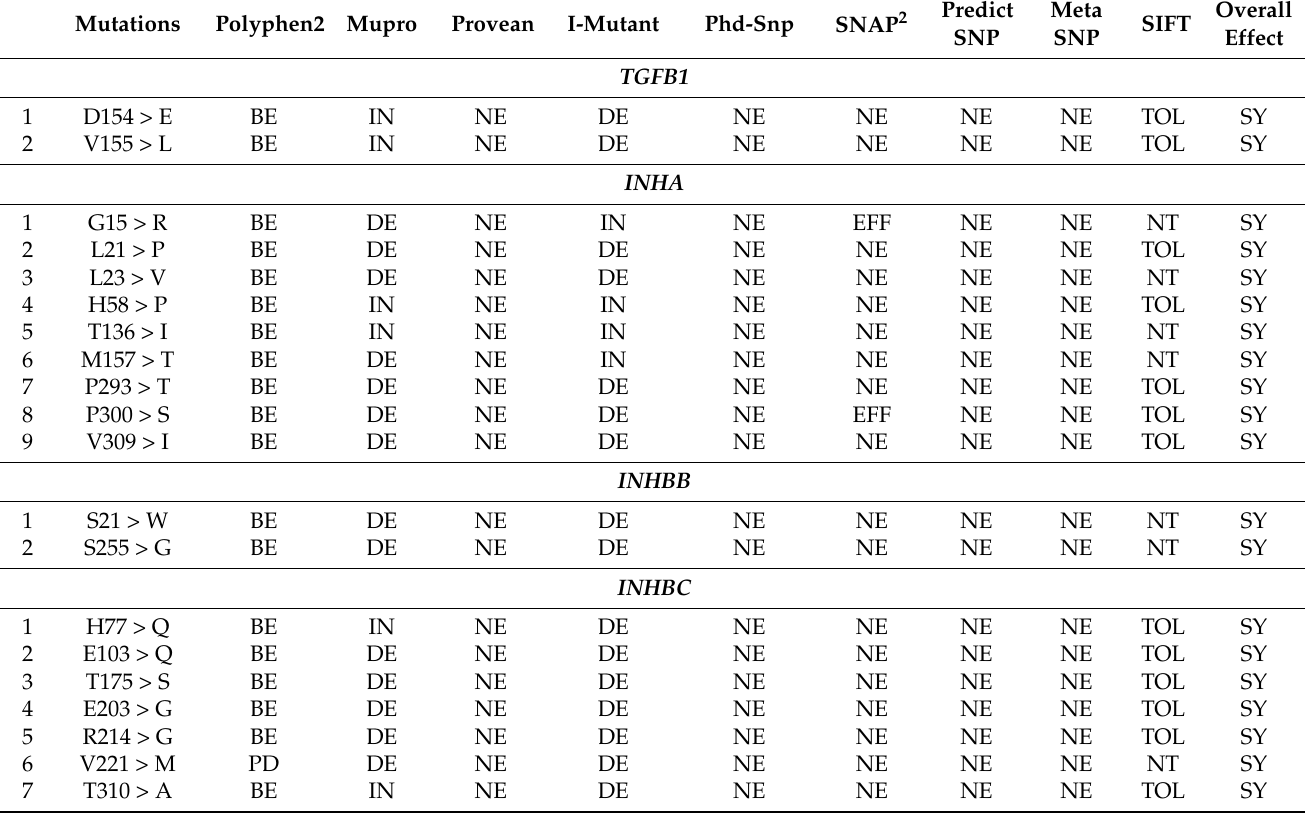
Table 5. Functional effects of mutations in different TGF- β gene family